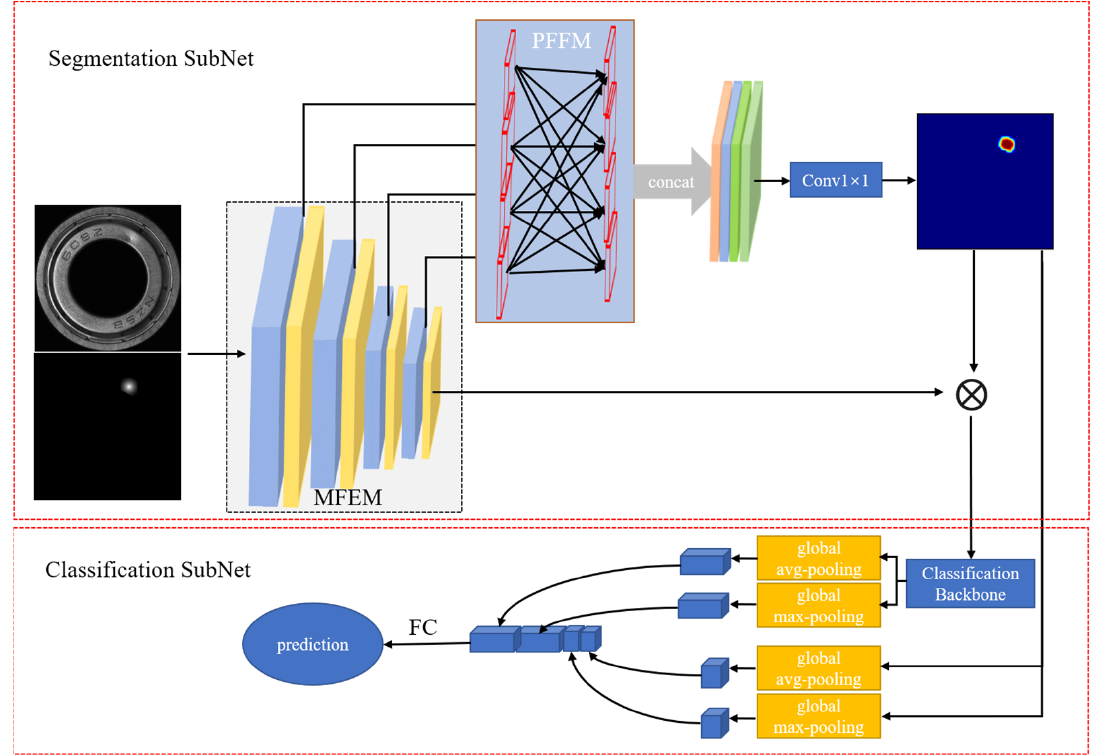
Figure 3. Details of the proposed PMG-Net. First input the image to extract the features of different stages in MFEM. Then, the extraction feature is then passed through the PFFM module fusion fea- tures, and the features adjustment dimension after 1 × 1 convolution will be fused to obtain the segmentation result. The segmentation results are multiplied with the last layer of MFEM to get enhanced features as the input of the classification network. Finally, the features by the classification backbone are extracted and segmentation results are sent to the full connection layer through the global average and maximum pooling, and the final prediction results are obtained.